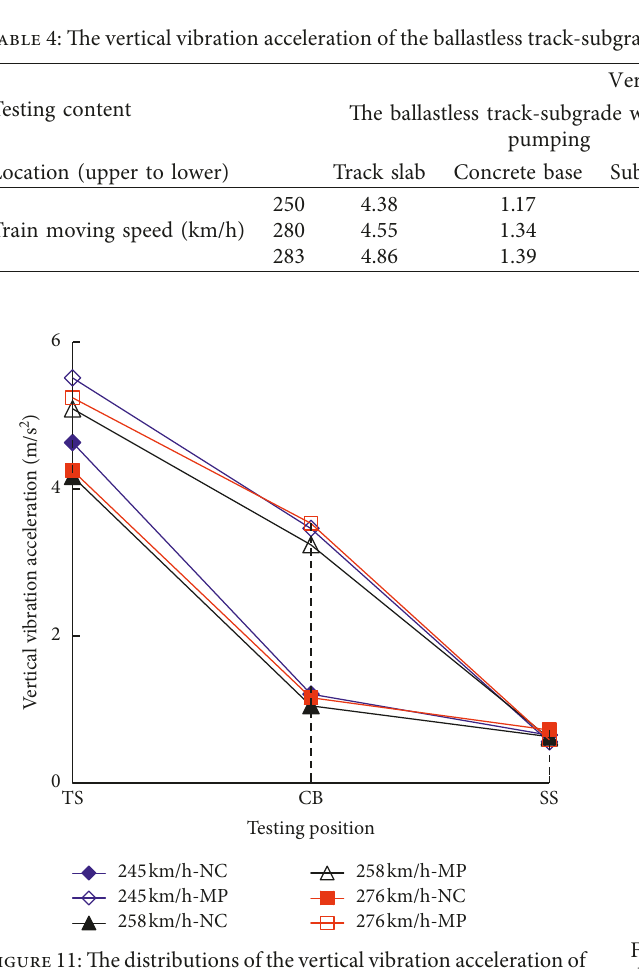
Figure 11: The distributions of the vertical vibration acceleration of the ballastless track-subgrade with and without mud pumping. NC, the subgrade bed under the normal condition (or without mud pumping); MP, the subgrade bed with mud pumping; TS, test position on the track slab; CB, test position on the concrete base; SS, test position on the subgrade surface.